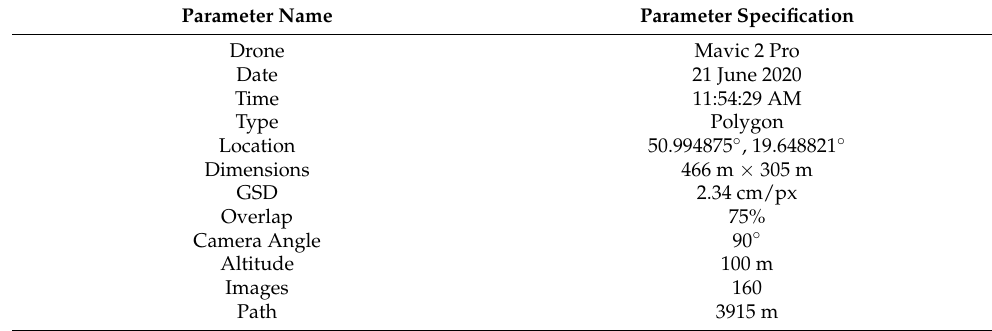
Table 1. UAV flight mission